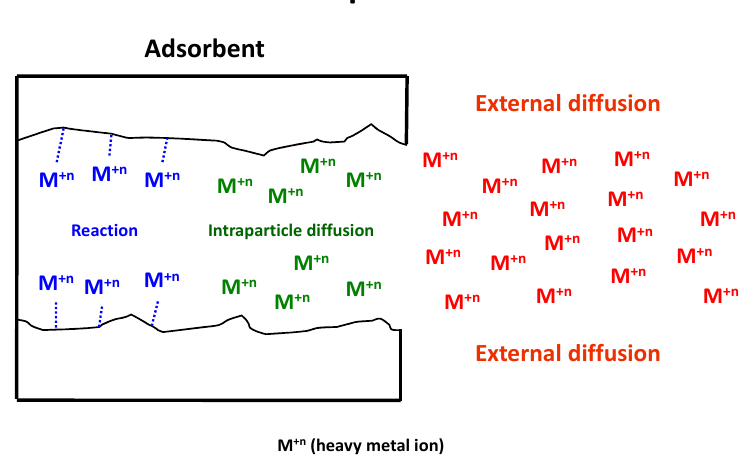
Figure 2. Mechanism of the adsorption of an adsorbate onto an